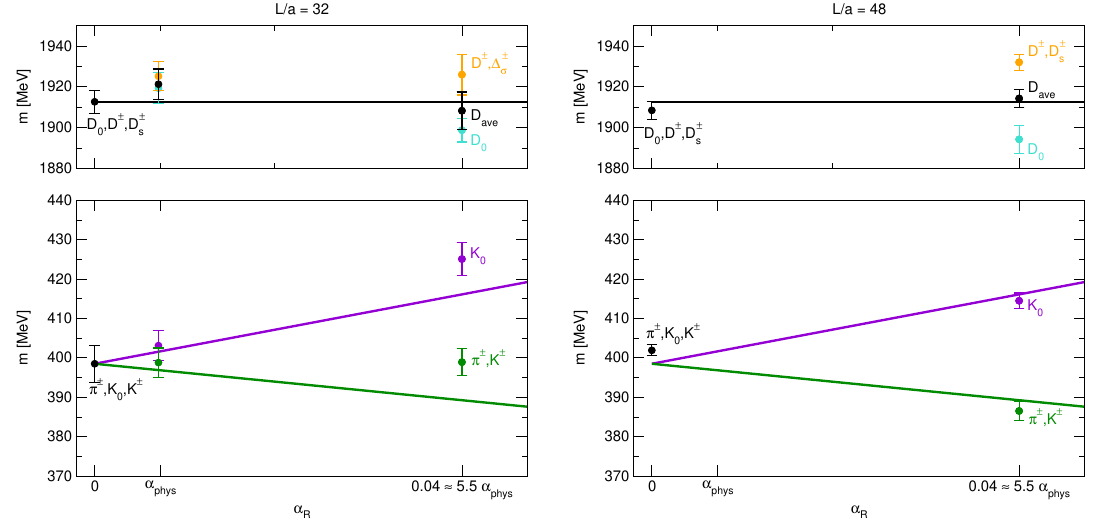
Figure 1 . The solid lines are the target values for the K 0 mass (purple), the K ± mass (green), the average D mass M D = 1 ( M + M D + M ) (black) as functions of α R , determined by D ± D ± s 3 ave 0 solving the tuning conditions given in eq. (2.4). In the left plots, the data points with error are meson masses calculated on the ensemble A400a00b324 ( α R = 0 ) and on the reweighted ensembles A380a07b324+RW1 ( α R ' 1 / 137 ) and A360a50b324+RW2 ( α R ' 0 . 04 ). In the right plots, the data points with error are meson masses calculated on the ensembles B400a00b324 ( α R = 0 ) and C380a50b324 ( α R ' 0 . 04 ). These correspond to our best-tuned ensembles. The comparison between left and right plots indicates how finite-volume effects affect the tuning. For an overview of our gauge ensembles, see section 3.2. The calculation of meson masses and φ observables is presented in section 3.3. Values in MeV are obtained by using the reference value (8 t 0 ) 1 / 2 = 0 . 415 fm